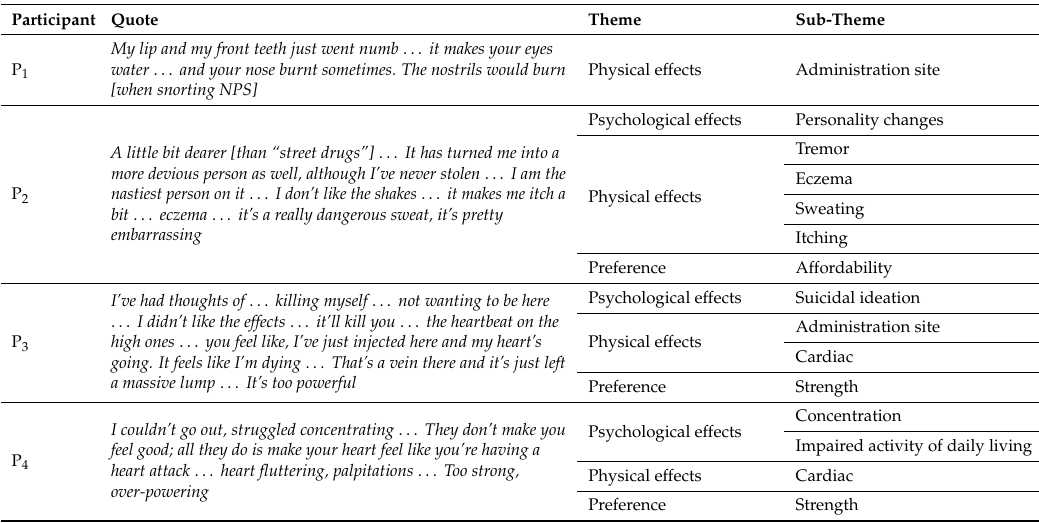
Table 4. Negative experiences associated with NPS use. A list of all the themes and sub-themes, with respective quotes by